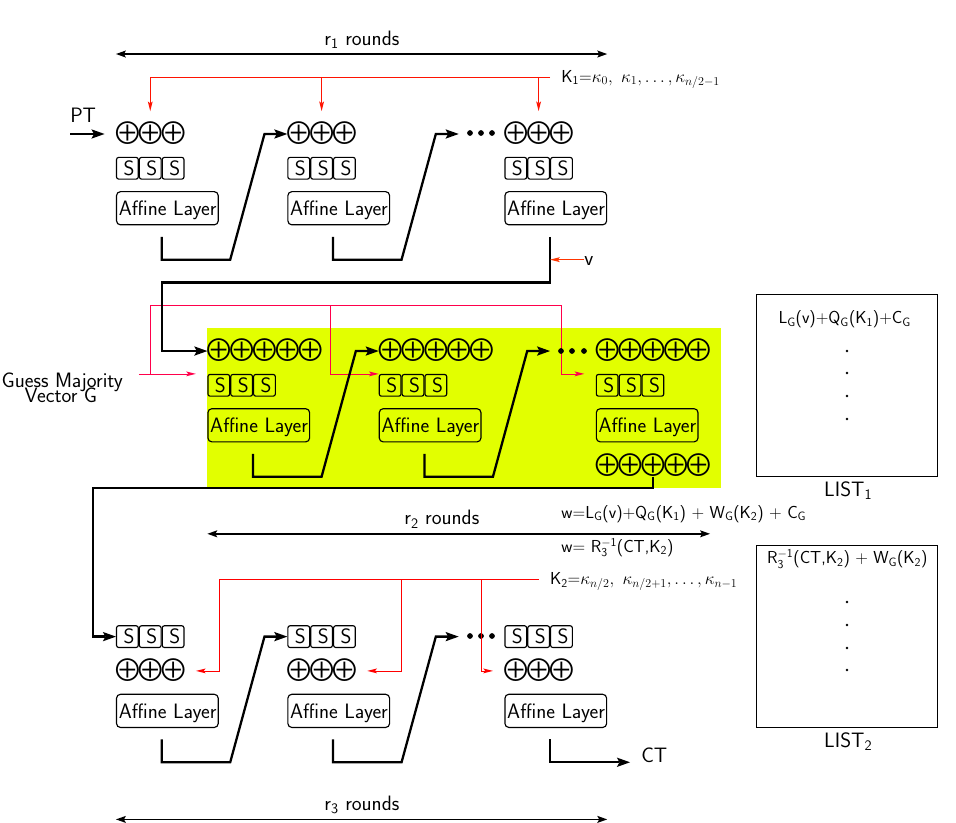
Figure 5: MITM on r 1 + r 2 + r 3 rounds with partial S-box layers. Note that the first r 1 and last r 3 rounds have been transformed as per the procedures explained in Figures 3, 4. yellow background) so that they become